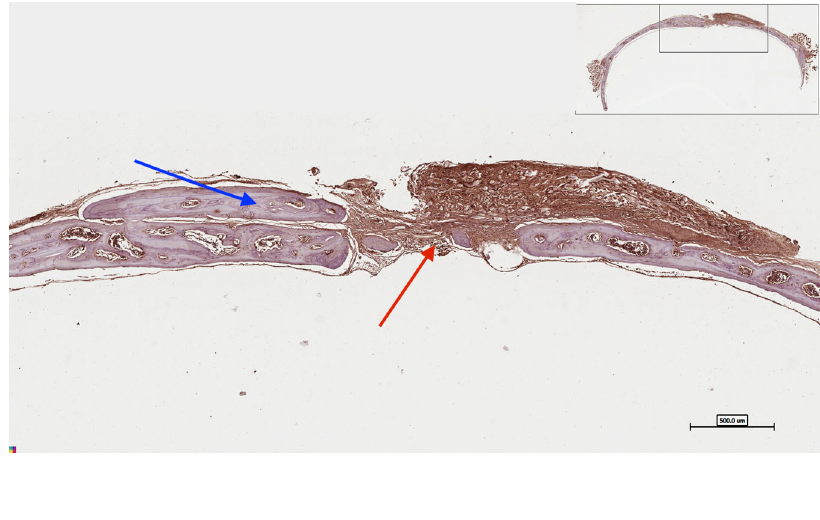
Fig. 14 Higher magni fi cation for the centre of the defect showing numerous bone spicules (blue arrows) surrounded with connective tissue that shows positive intake of osteopontin (OPN)